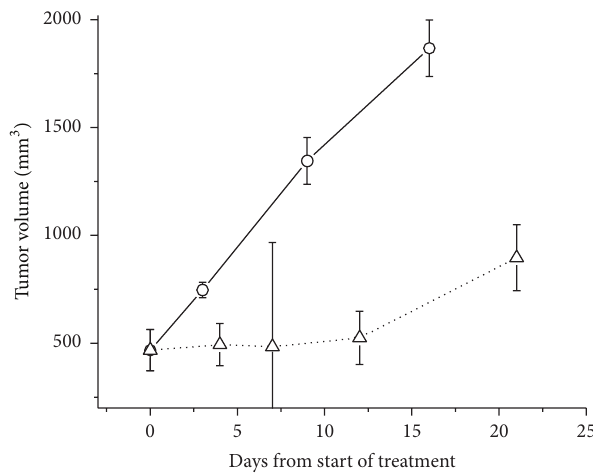
Figure 1: The tumor growth response of UT-SCC-14 xenografts to a dose of 15Gy. Flank tumors were either irradiated with 15 Gy ( 󳵻 ) or sham-irradiated (O) and their growth was monitored over time with